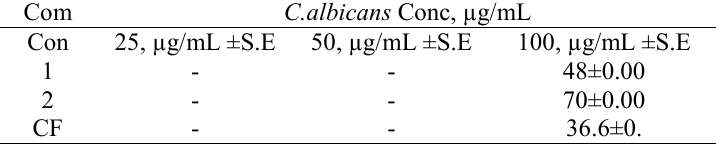
Table 3. Antifungal activity of the synthesized